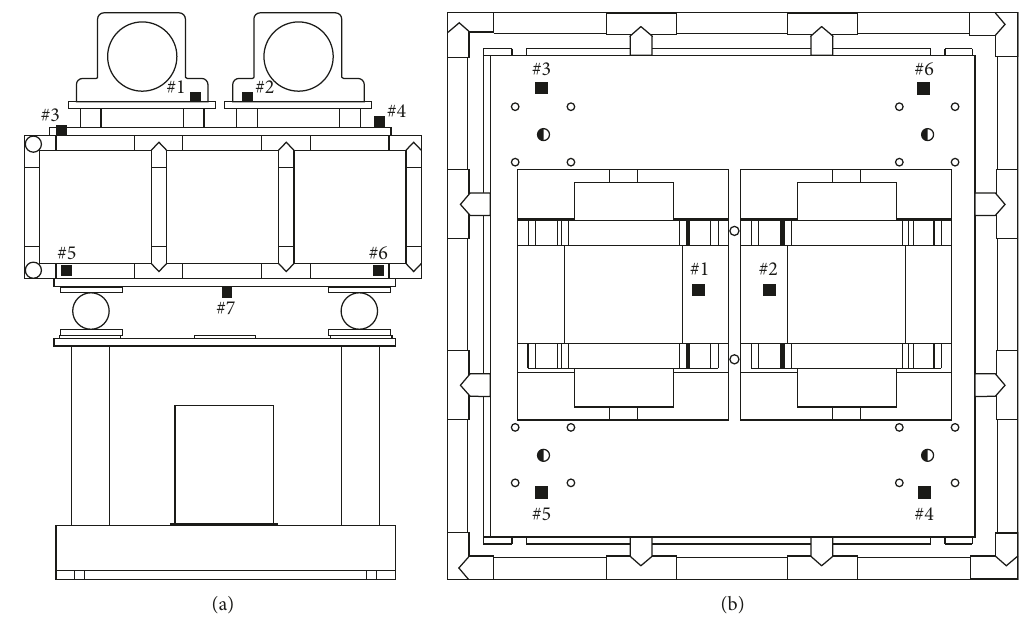
Figure 8: Installation positions of the acceleration sensors: (a) elevation and (b) horizontal layout.